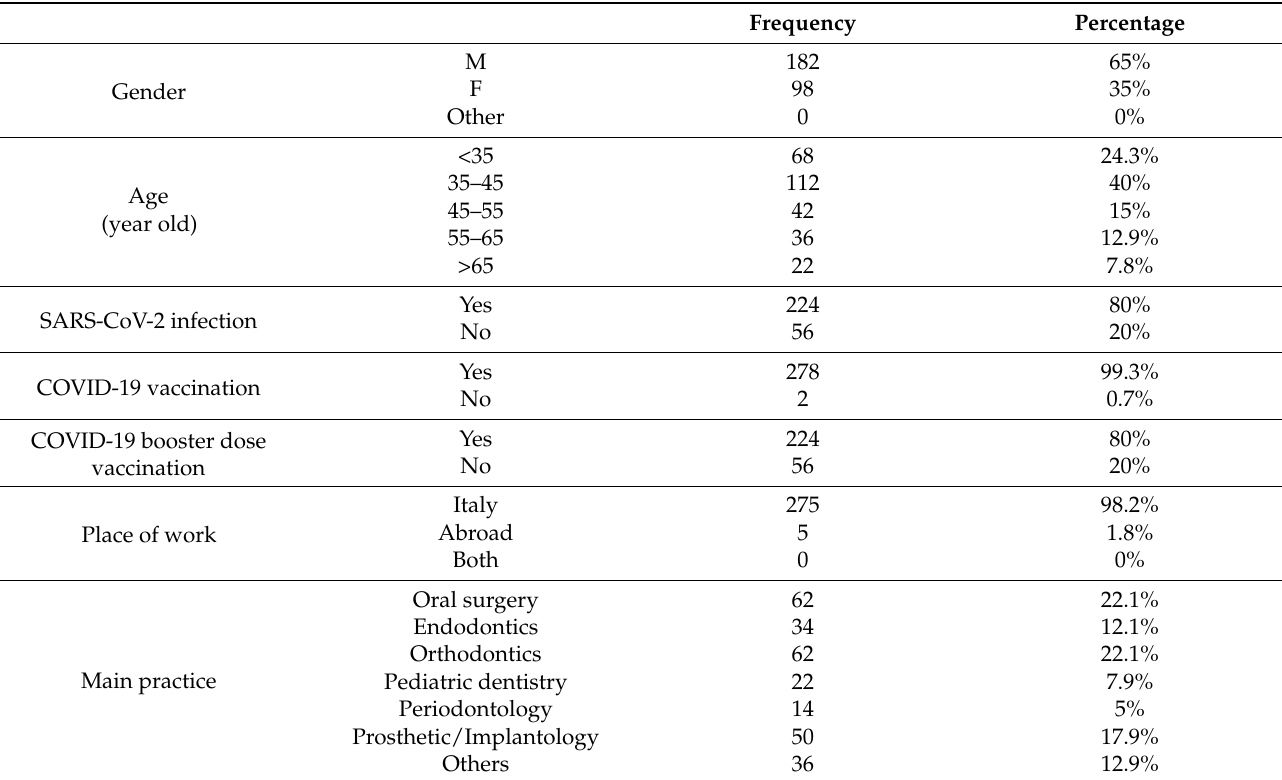
Table 1. Personal data and professional characteristics of